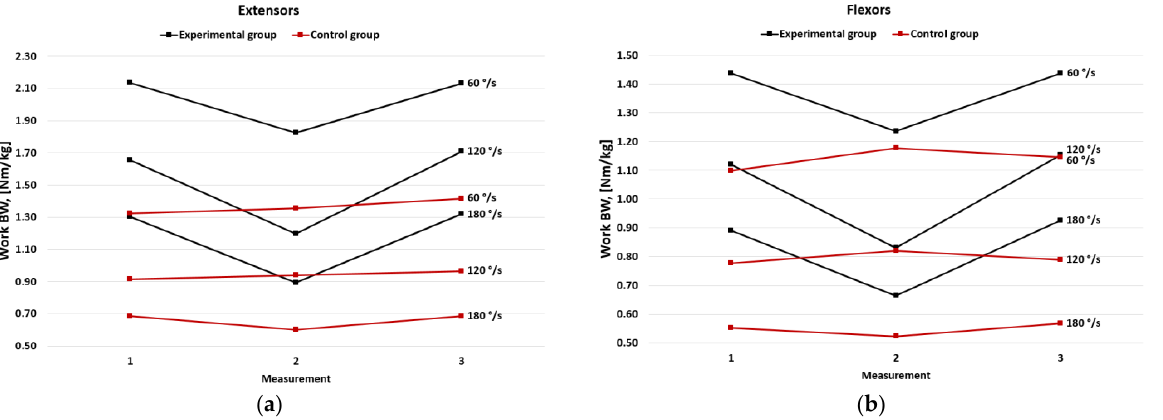
Figure 3. Mean of work per repetition per body weight in the experimental and the control group for ( a ) extensors and ( b ) flexors.